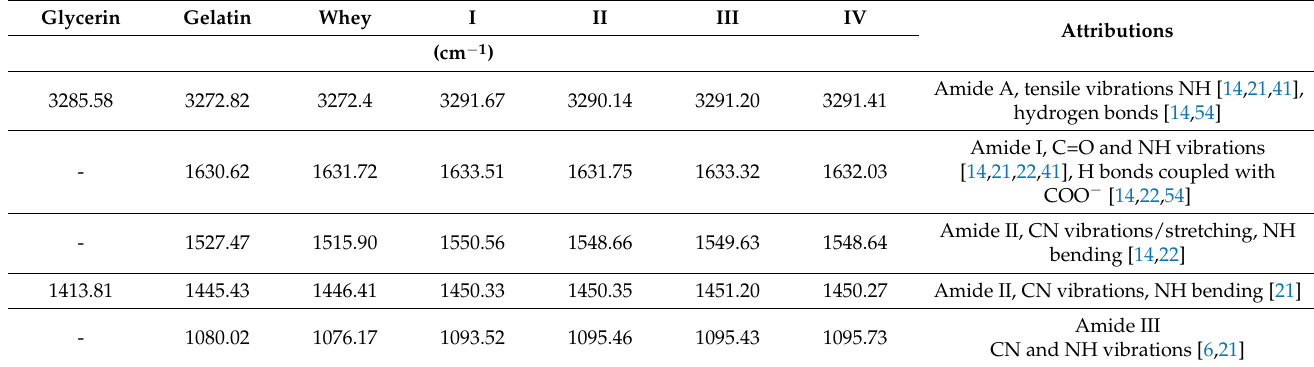
Table 4. The main vibration bands of hydrogels and their